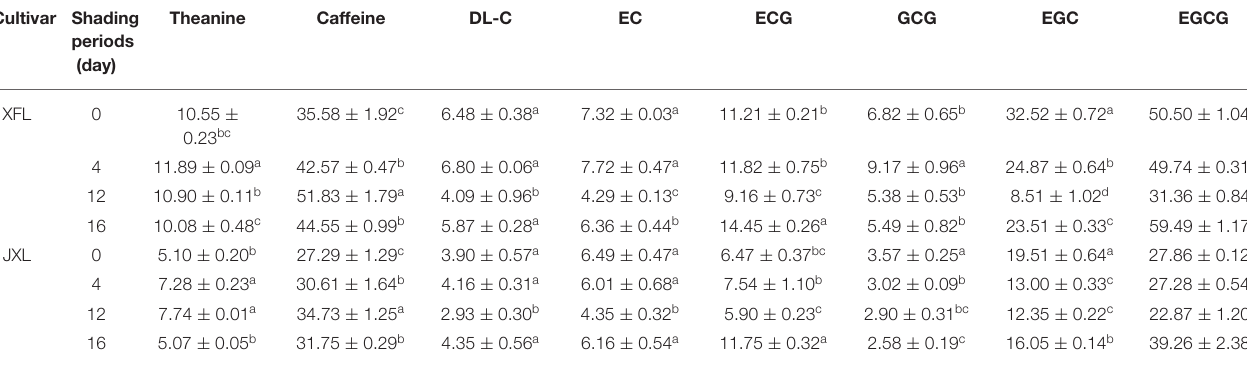
TABLE 1 | Biochemical compositions of leaves in two tea cultivars under different shading periods. Cultivar Shading Theanine Caffeine DL-C periods (day)